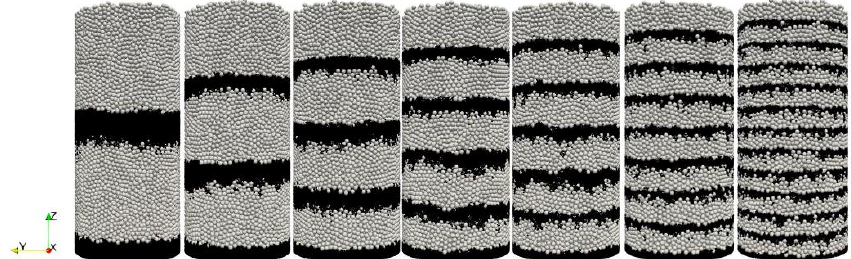
Figure 9. Stock columns with a different number of layers.